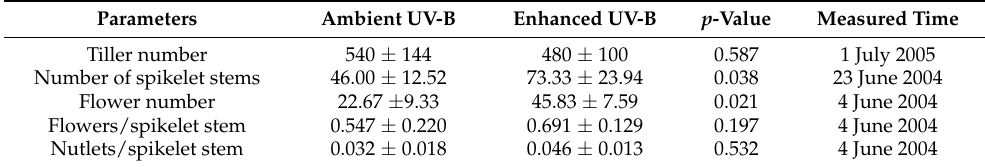
Table 4. Effects of enhanced UV-B on the number of tillers and flowers of K. humilis .